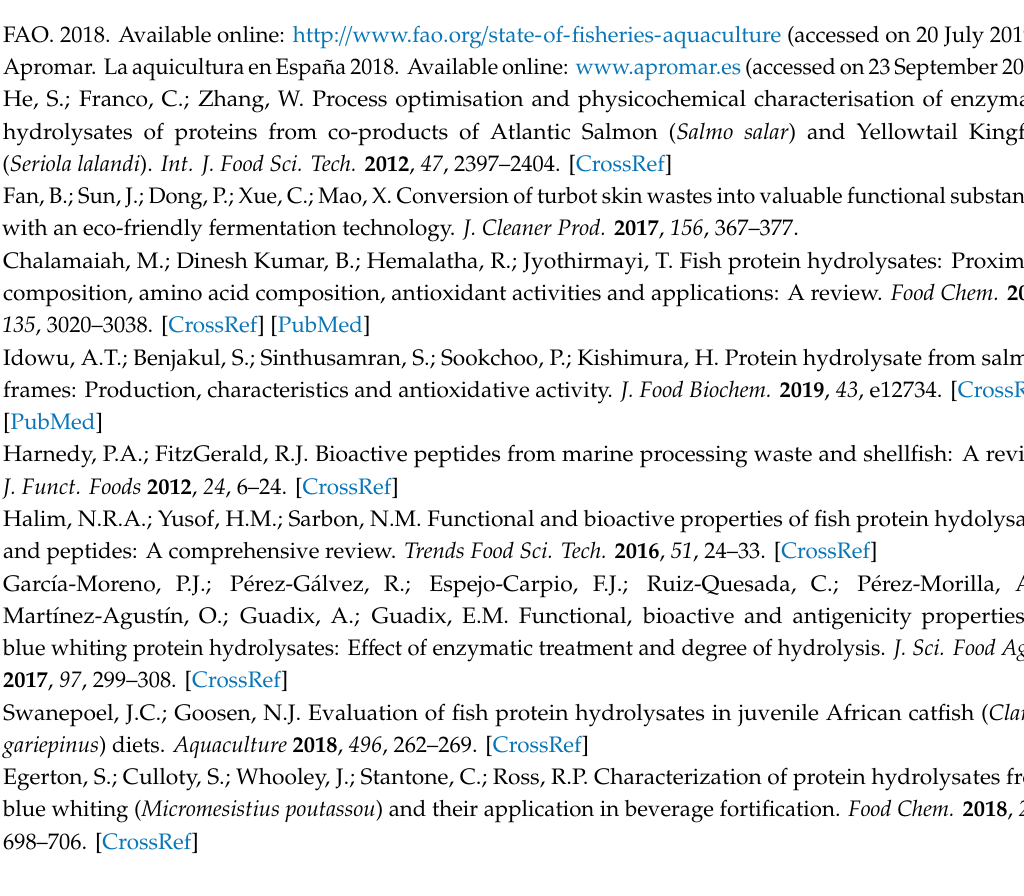
Figure S1: Pictures of the turbot by-products (raw materials), Figure S2: Pictures describing the production of turbot hydrolysates, Table S1: Experimental design for the optimization of the FPHs, Table S2: Proximate composition of turbot by-products, Table S3: Kinetic parameters from Weibull equation modeling the time course of the hydrolysis degree, Table S4: Fatty acids content from fish oils recovered from di ff erent wastes of